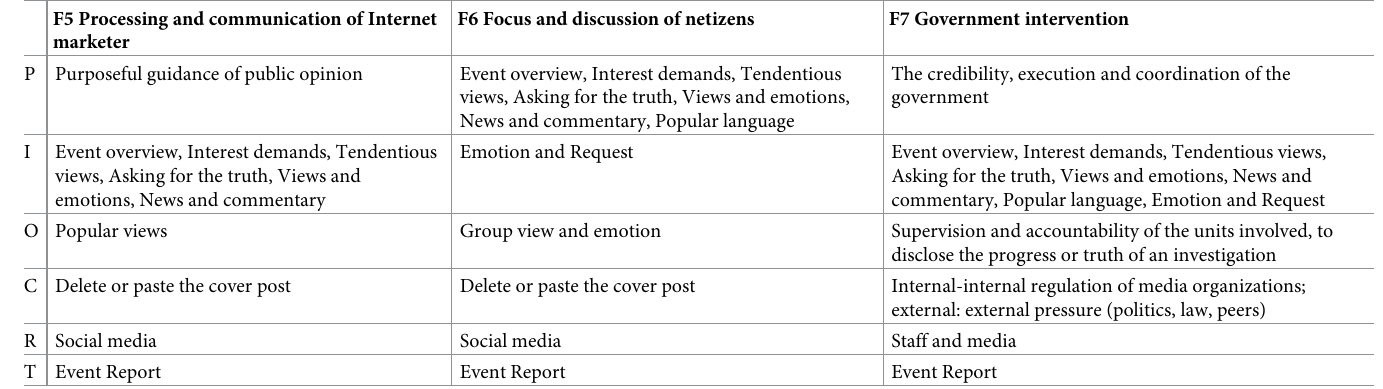
Table 2. The functions in the